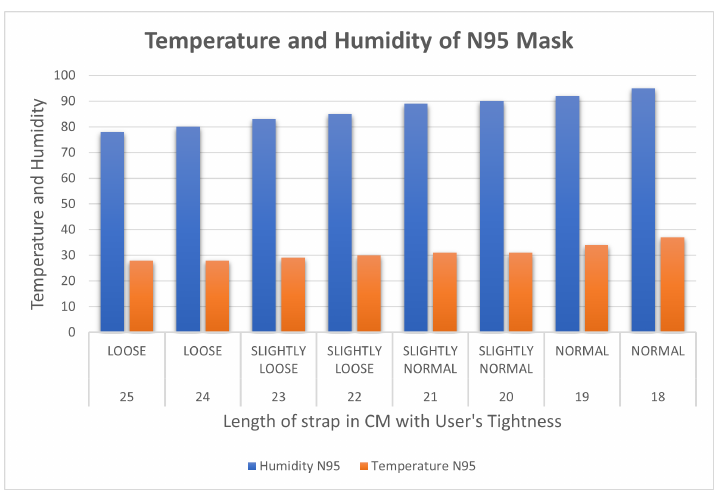
Figure 14. Variation of temperature in Celsius and humidity inside the KN95